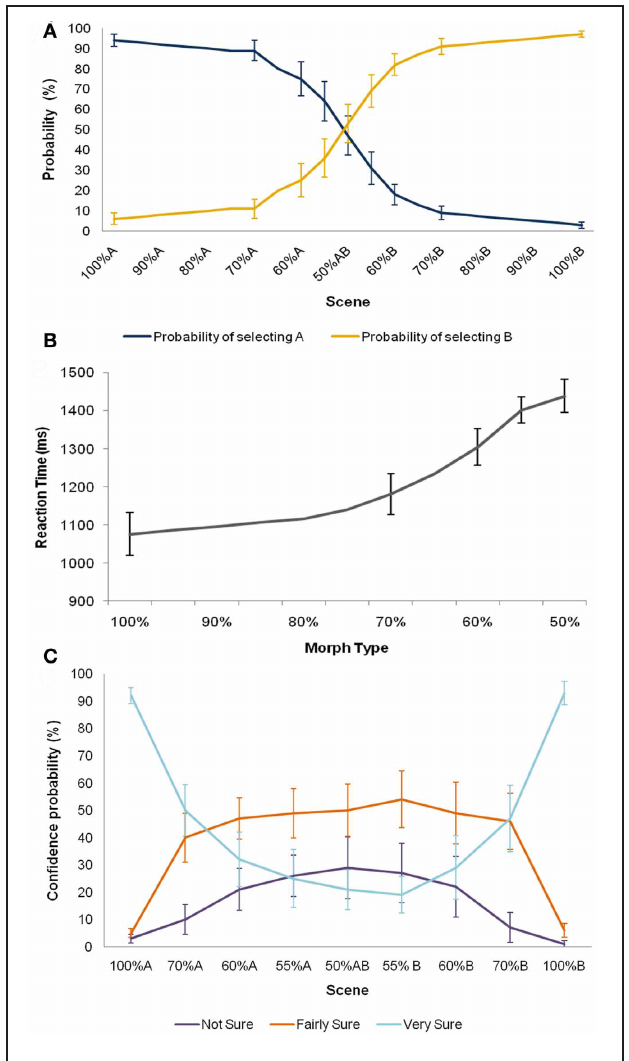
psychometric function for accuracy for the 16 participants showed a sigmoid profile. (B) Participants were less accurate and slower with increasing noise in the sensory input. (C) Participants’ pattern of confidence ratings also followed the expected distribution. Morphs approaching the two original scenes were afforded higher confidence ratings, and more ambiguous morphs lower